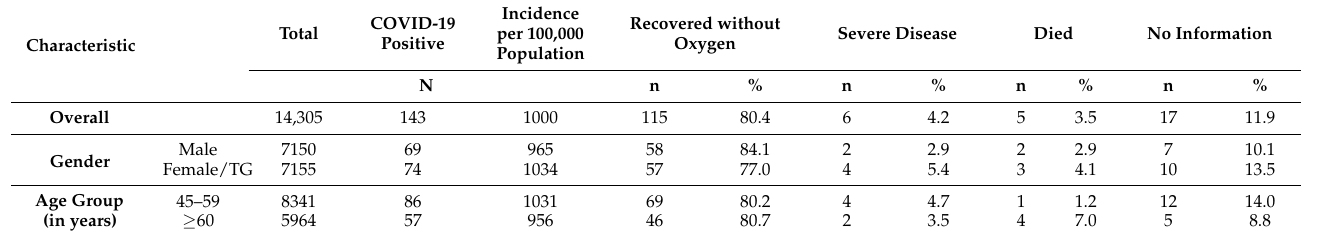
Table 3. COVID-19 incidence and its outcomes among the individuals ≥ 45 years in the COVID-19 vaccine effectiveness cohort study, Chennai, 2021 (N =